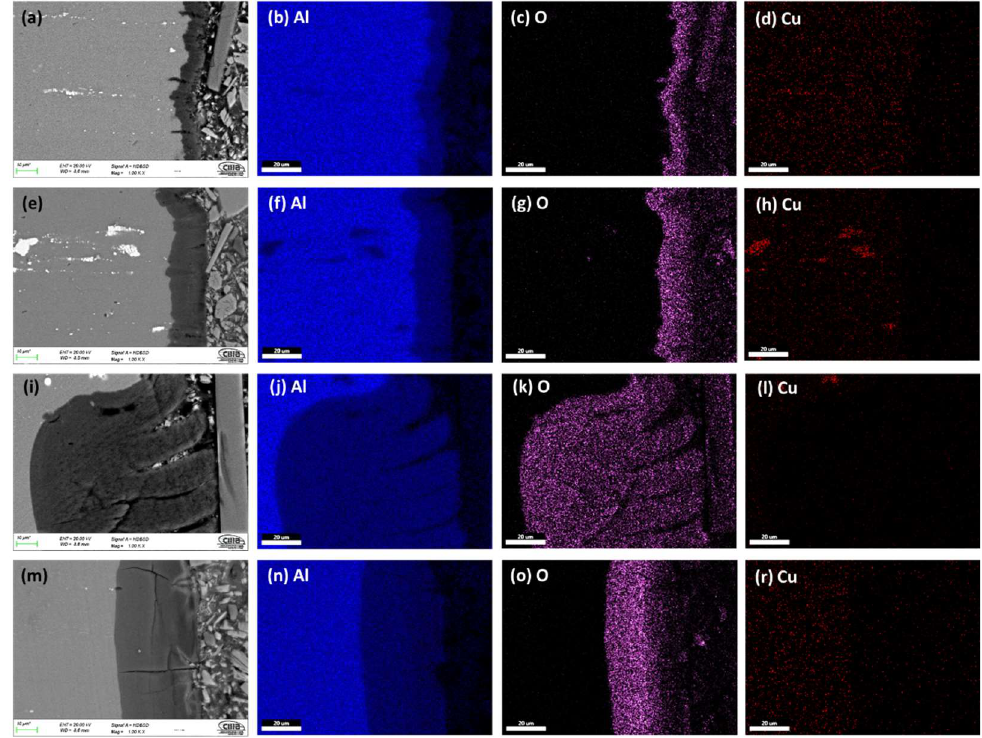
Figure 4. SEM-BSE cross-section of anodized samples of AA2024 at 3 A/dm 2 : ( a ) 4.5A C1M S5, ( e ) 4.5A C1M S10, ( i ) 4.5A C1M, and ( m ) 4.5A S1M. Element content; Aluminum ( b , f , j , n ), Oxygen ( c , g , k , o , and Copper ( d , h , l , r ).